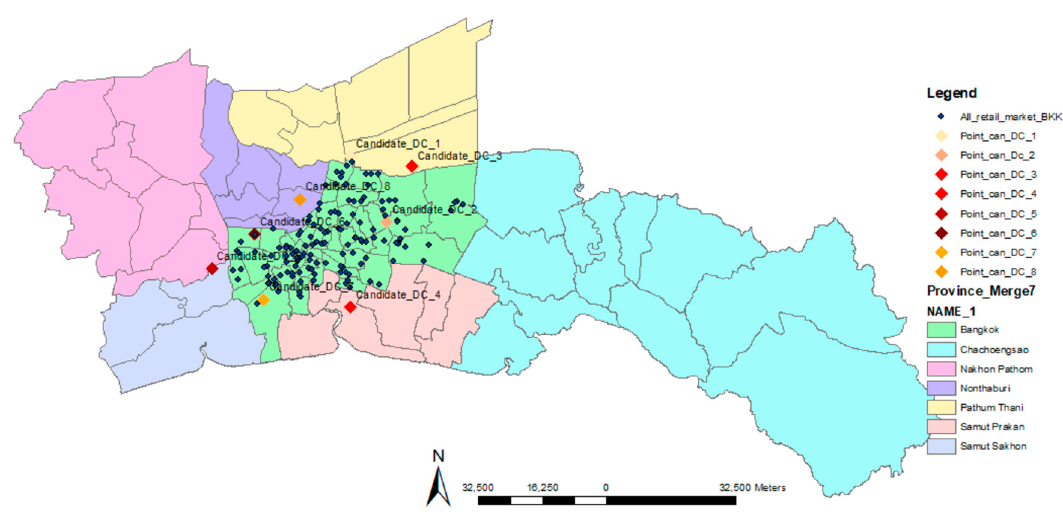
Figure 3. Point of main retail markets on ArcGIS Figure 4. Point of main retail markets on ArcGIS software.